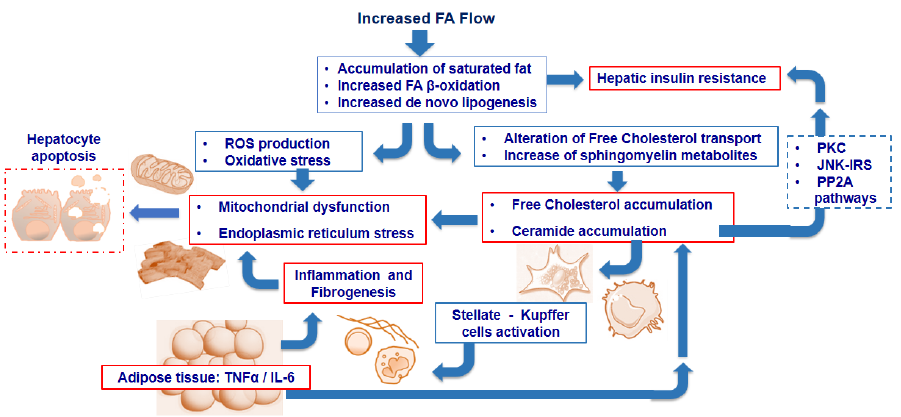
Figure 2. Excess fat accumulation promotes increased “ de novo lipogenesis ” (DNL) and fatty acid (FA) beta-oxidation. These mechanisms lead to reactive oxygen species (ROS) generation which induces oxidative mitochondrial damage and endoplasmic reticulum (ER) stress. In parallel, the accumulation of free (non-esterified) cholesterol and ceramides enhances both mitochondrial dysfunction and ER stress, and induces the activation of stellate cells as well as Kupffer cells, thus promoting inflammation and fibrosis. Furthermore, tumor necrosis factor alpha (TNF α ) and interleukin-6 (IL-6) from adipose tissue enhance the inflammatory process and promotes ceramide accumulation, contributing to insulin resistance through different pathways. Ultimately, these events trigger the hepatocyte apoptotic pathway, leading to cell death. PKC: protein kinase; CJNK-IRS: c-Jun N-terminal kinase-insulin receptor substrate; PP2A: Protein Phosphatase